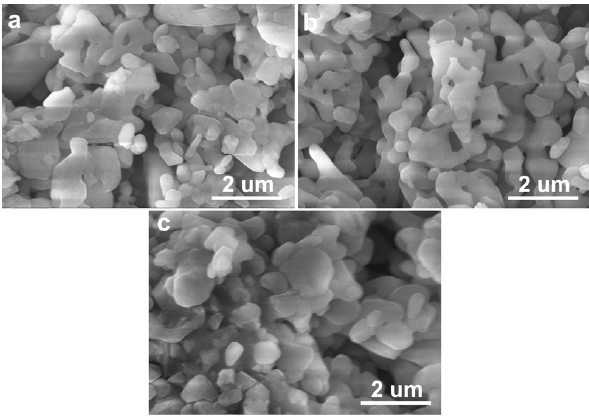
Figure 3. SEM images of porous Al 2 O 3 ceramics sintered at 1300 °C ( a ); 1350 °C ( b ) and 1400 °C ( c ), with the Al 2 O 3 content at 40 vol.% in the ceramic slurries.